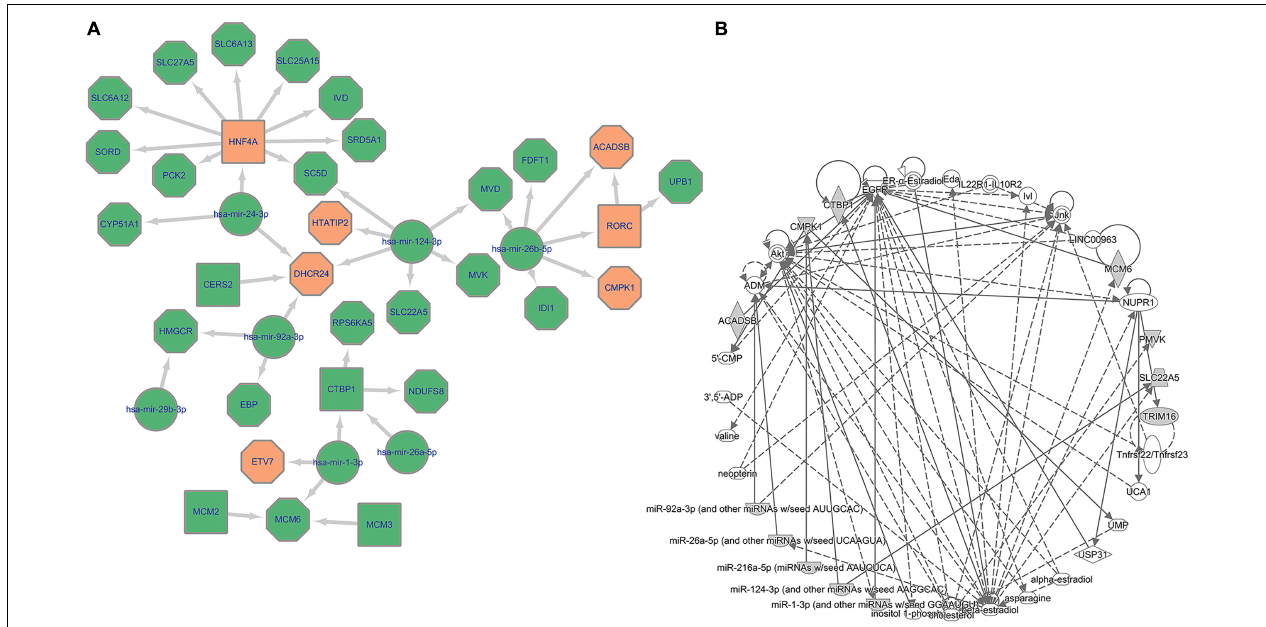
FIGURE 5 | Multi-scale network exploration of HCC mechanism. (A) Core miRNA relation network of potential therapeutic targets. The octagon represents metabolic genes while the square represents TFs and the circle represents miRNAs; The orange color represents genes/TFs that have been experimentally validated as crucial genes in HCC tumor cells. (B) Biological connection of 34 genes (28 candidate genes and top 6